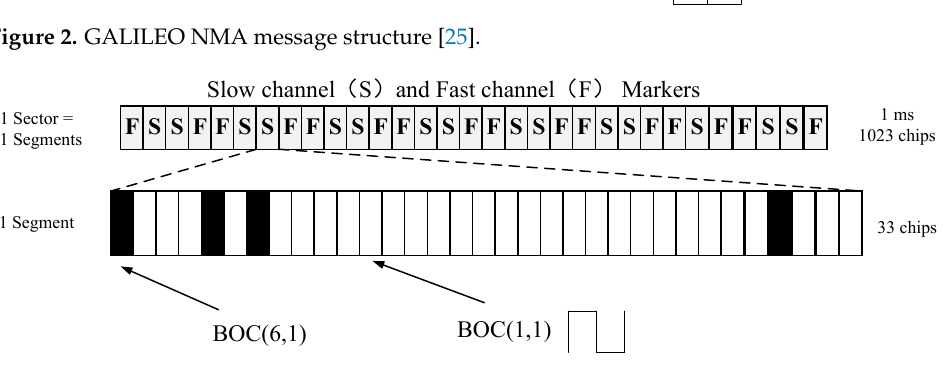
Figure 3. CHIMERA spreading code [26].